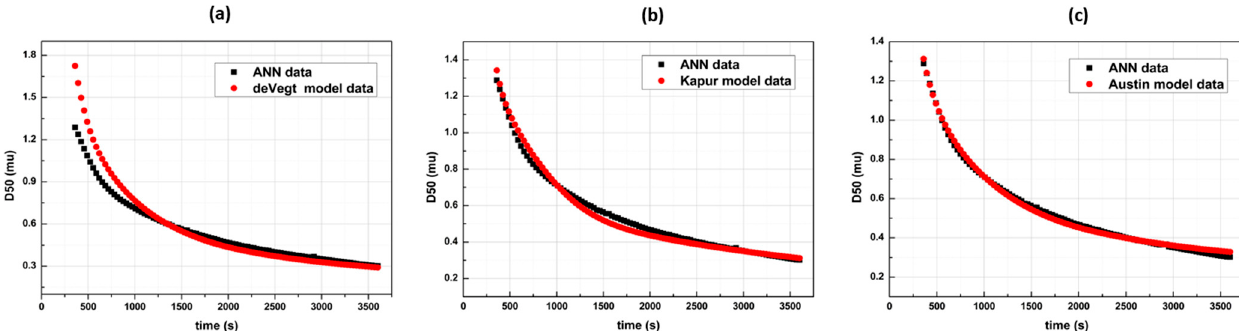
Figure 5. Breakage parameter c effect on the size comminution profile . The de Vegt model’s breakage distribution function remained the same during the analysis as when combining Equations (5) and (6) the final form appears dependent on the (cid:3051)(cid:3036) (cid:3051)(cid:3037) size reduction ratio (Equation (30)). 𝑏(𝑖, 𝑗) = (cid:3436) (cid:3051) (cid:3284) (cid:3051) (cid:3285) (cid:3440) (cid:2869).(cid:2870)(cid:2873)